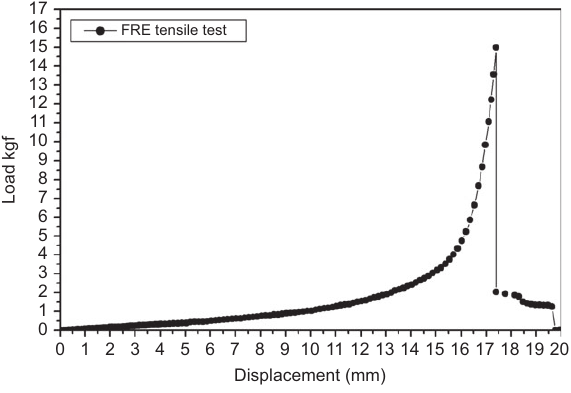
Figure 6 Load-displacement curve of the fiber-reinforced silicone rubber